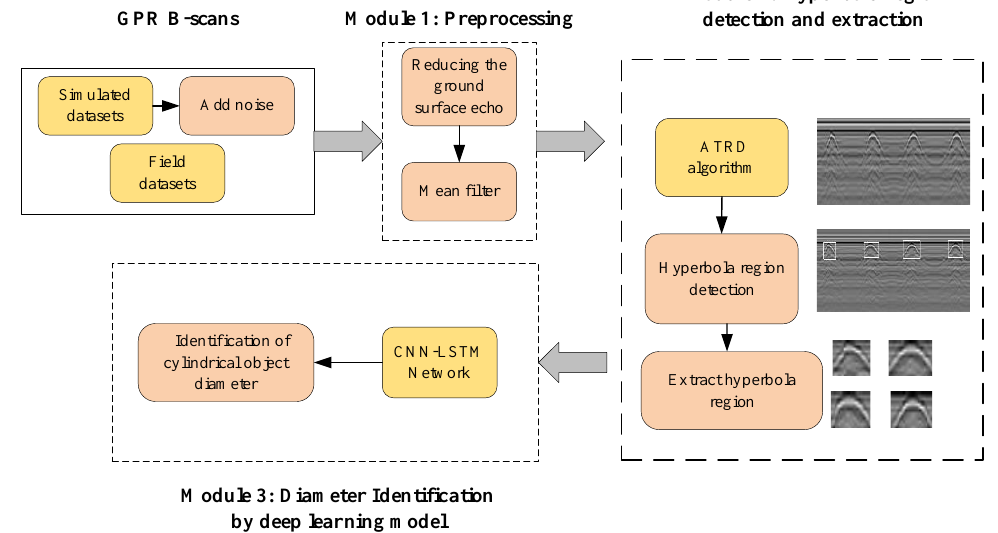
Figure 1. Illustration of GPR B-scans’ interpretation by the proposed scheme.